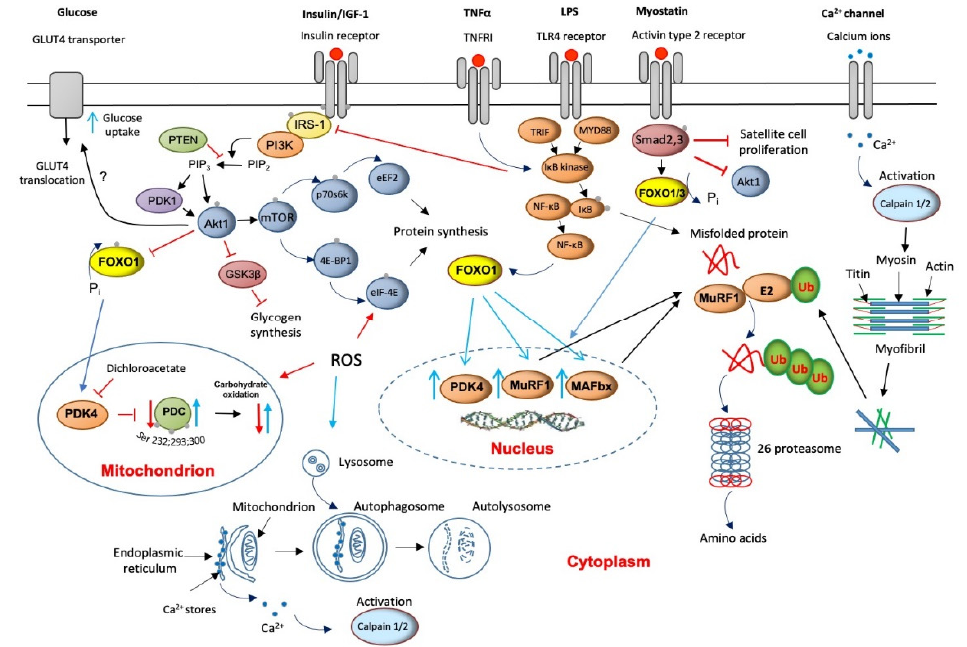
Figure 2. A schematic illustration of the main molecular mechanisms underlying muscle wasting and thereby to muscle fatigue (red lines/arrows indicate downregulation, blue lines/arrows indicate upregulation).